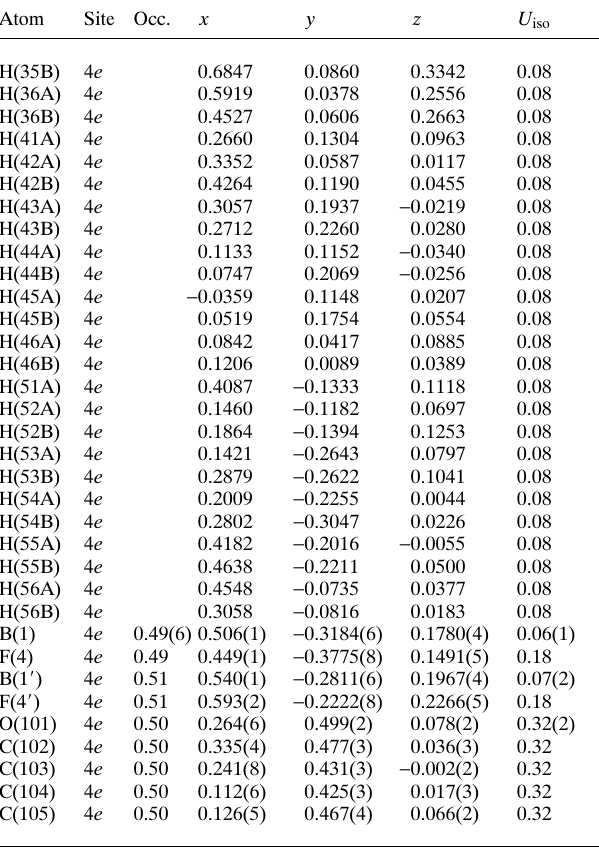
Table 2. Atomic coordinates and displacement parameters (in Å 2 ) . Atom Site Occ.